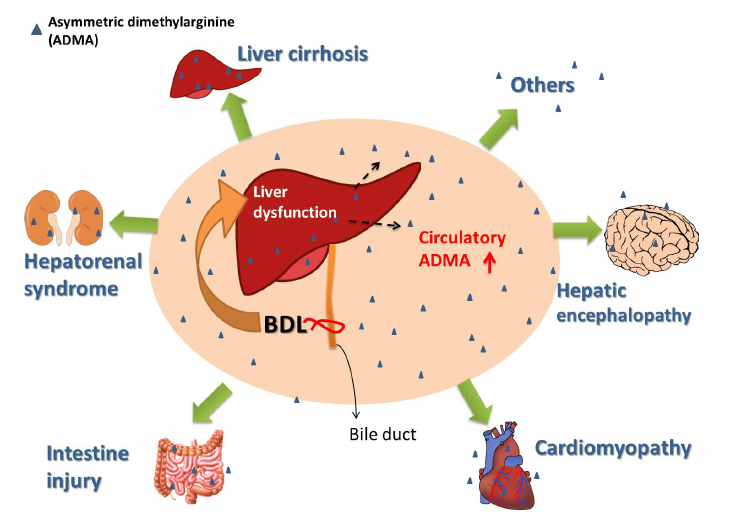
Figure 1. The role of increased circulatory asymmetric dimethylarginine (ADMA) in multiple organ damages in the bile duct ligation